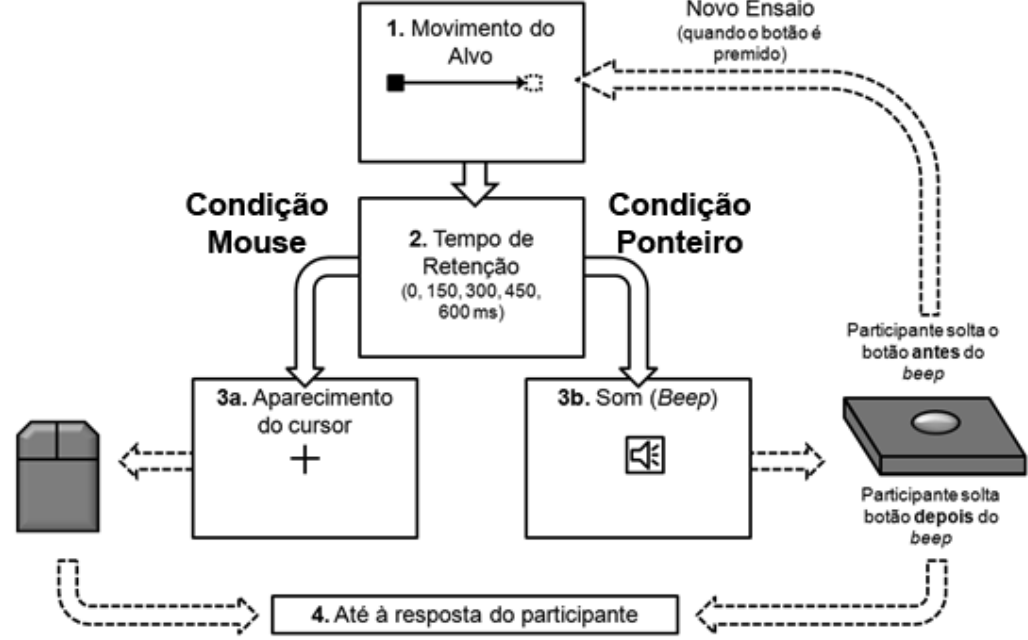
Figura 2 . Representação esquemática da sequência de eventos da experiência.